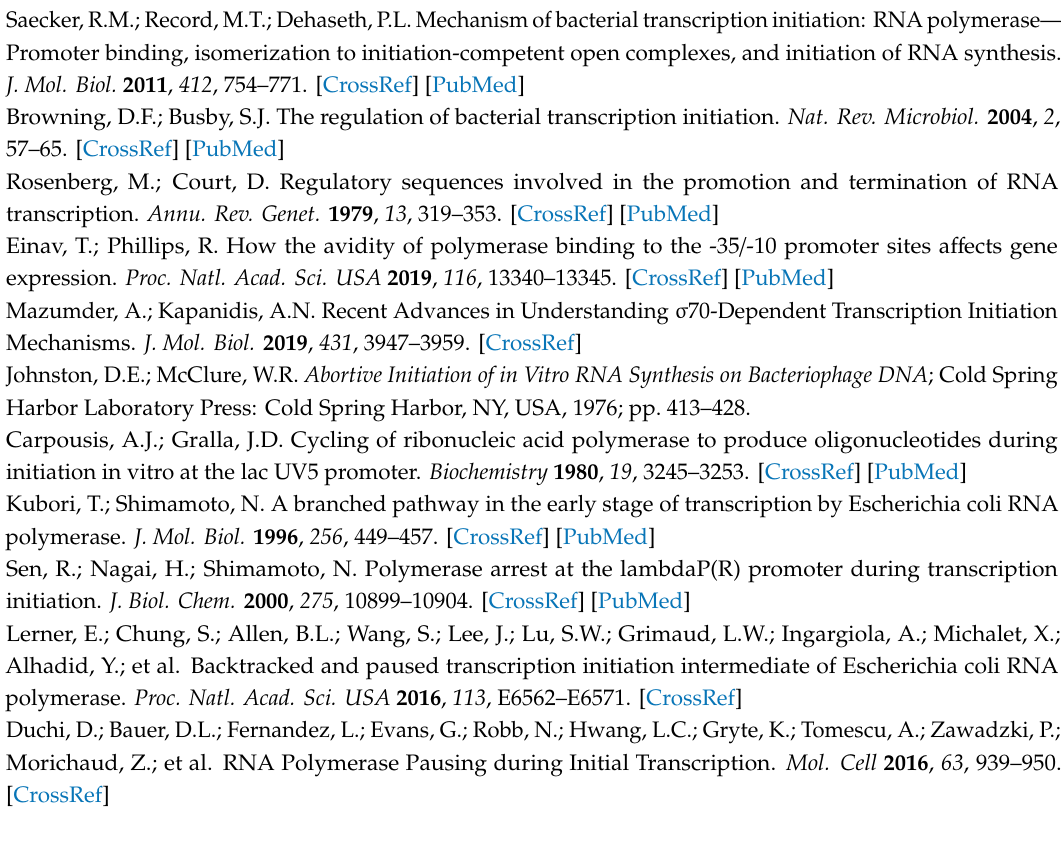
Table S1: Short RNET-seq reads that were mapped to TSS; Table S2: DNA Sequences of the in vitro transcription templates, Figure S1: In vitro transcription from 9 di ff erent promoters that focus on short transcripts and antisense transcripts, Figure S2: Assignment of the imino proton